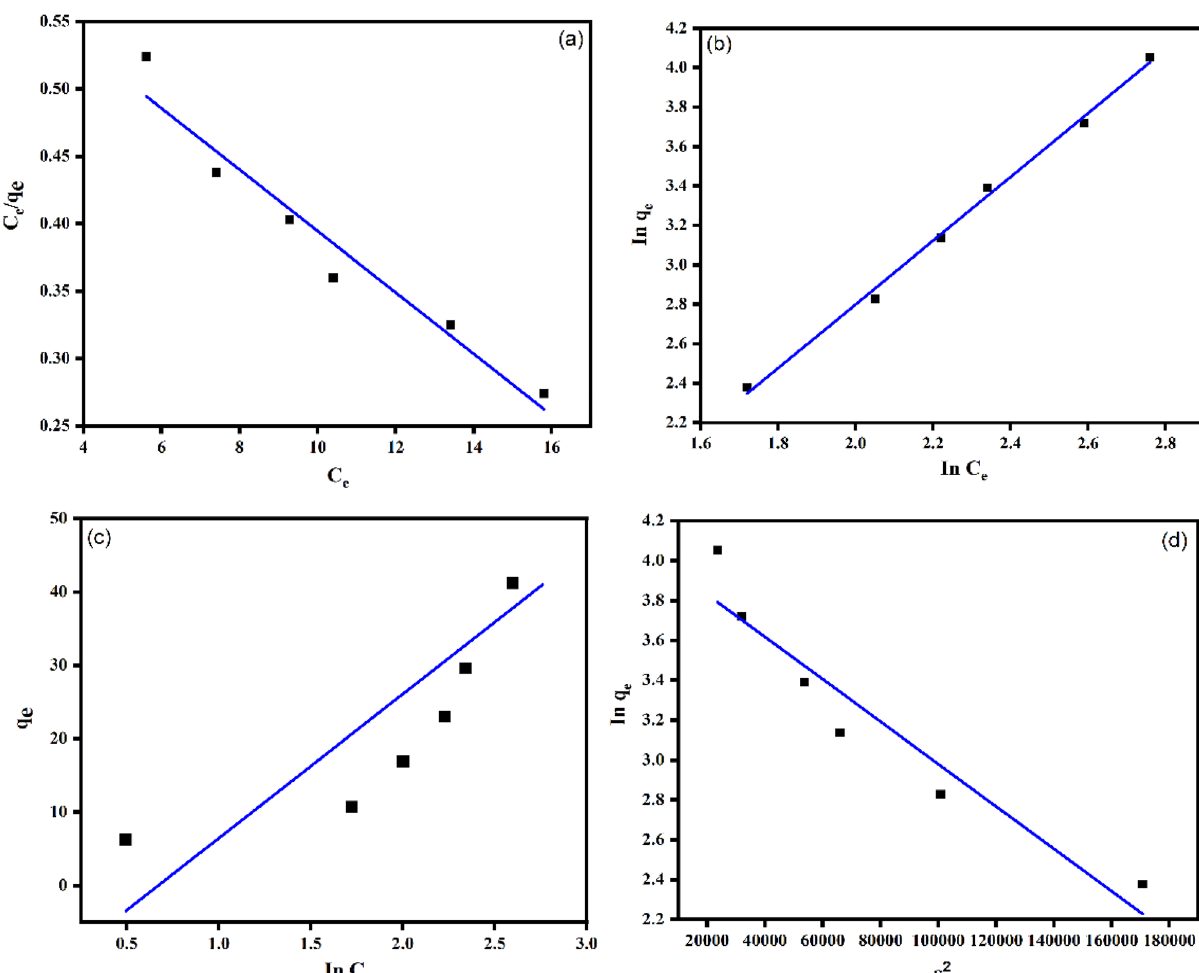
Figure 16. Linear isotherm plots of ( a ) Langmuir; ( b ) Freundlich; ( c ) Temkin and ( d ) D-R isotherm models for the MB dye adsorption onto PVA/CMC/TUR films.